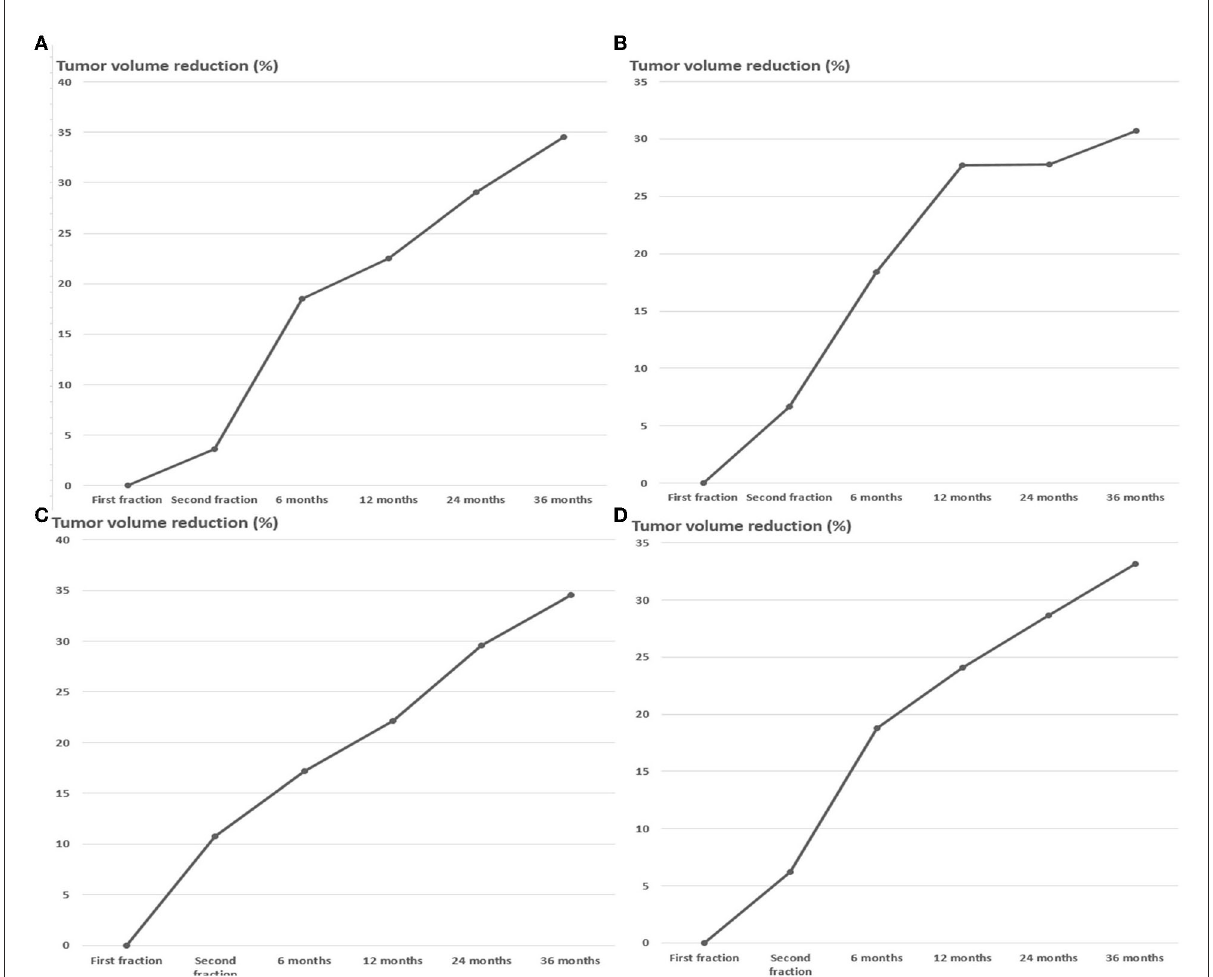
FIGURE2 Tumor volume trends for meningiomas of different initial volume after dose-staged radiosurgery (A) < 8 cc group, (B) 8–20 cc group, (C) > 20 cc group, (D) Combined group.